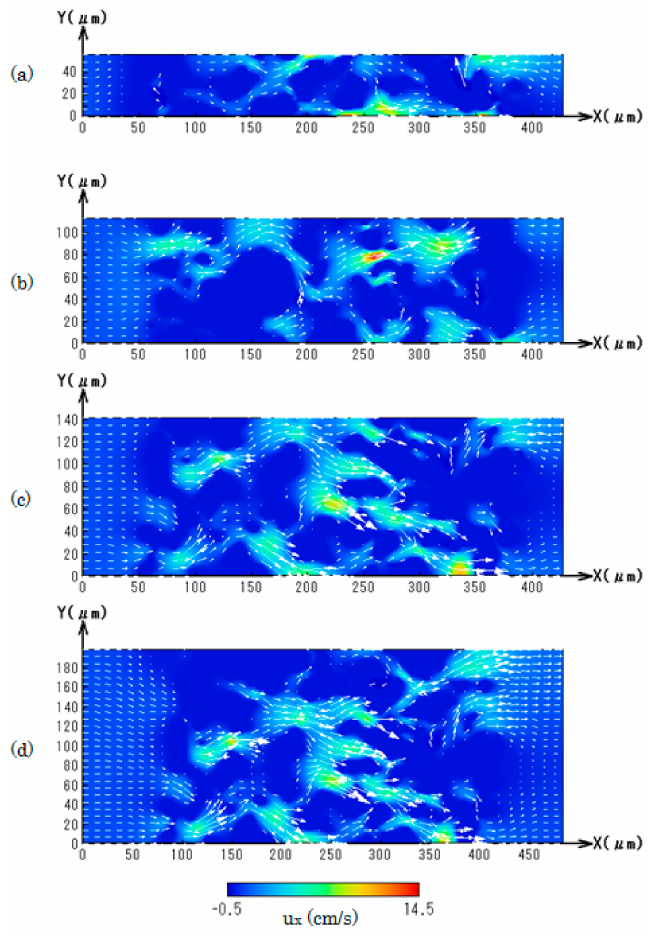
Figure 4. Distributions of velocity in X-direction of sample 1; ( a ) W = 57 µ m; ( b ) W = 114 µ m; ( c ) W = 142 µ m; ( d ) W = 189 µ m.